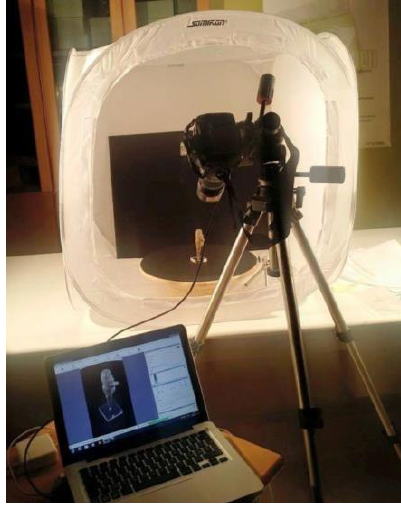
Figure 1. Instrumentation used for the photographic acquisition